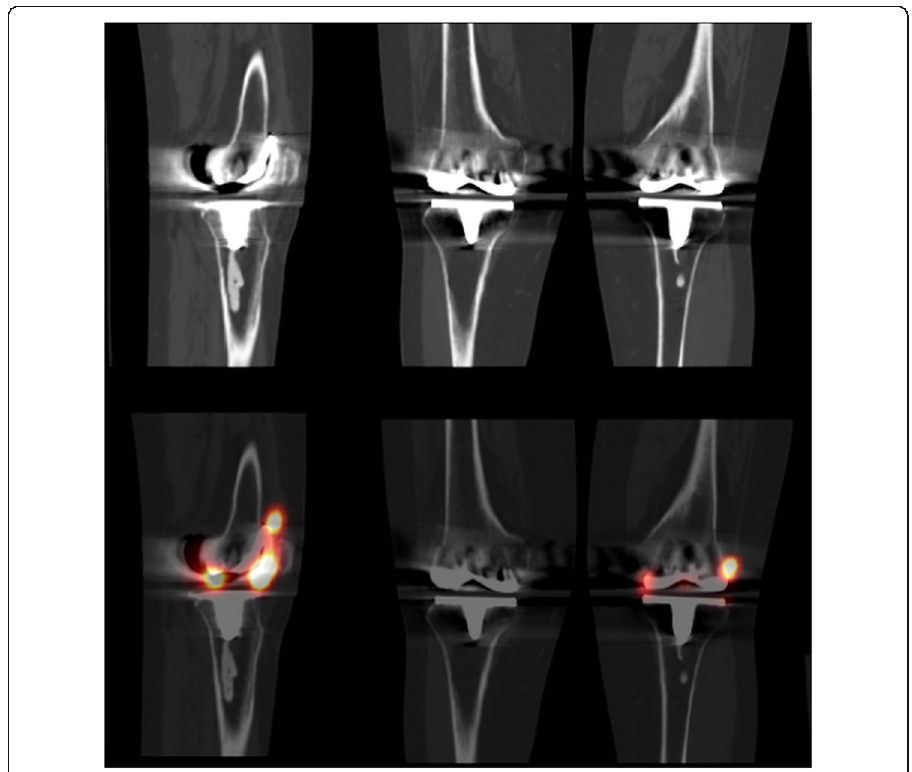
Fig. 2 Normal left knee total arthroplasty. Sagittal (left) and coronal (right) imaging with CT (top row) and fused SPECT/CT (bottom row) images showing normal tracer activity within the joint space